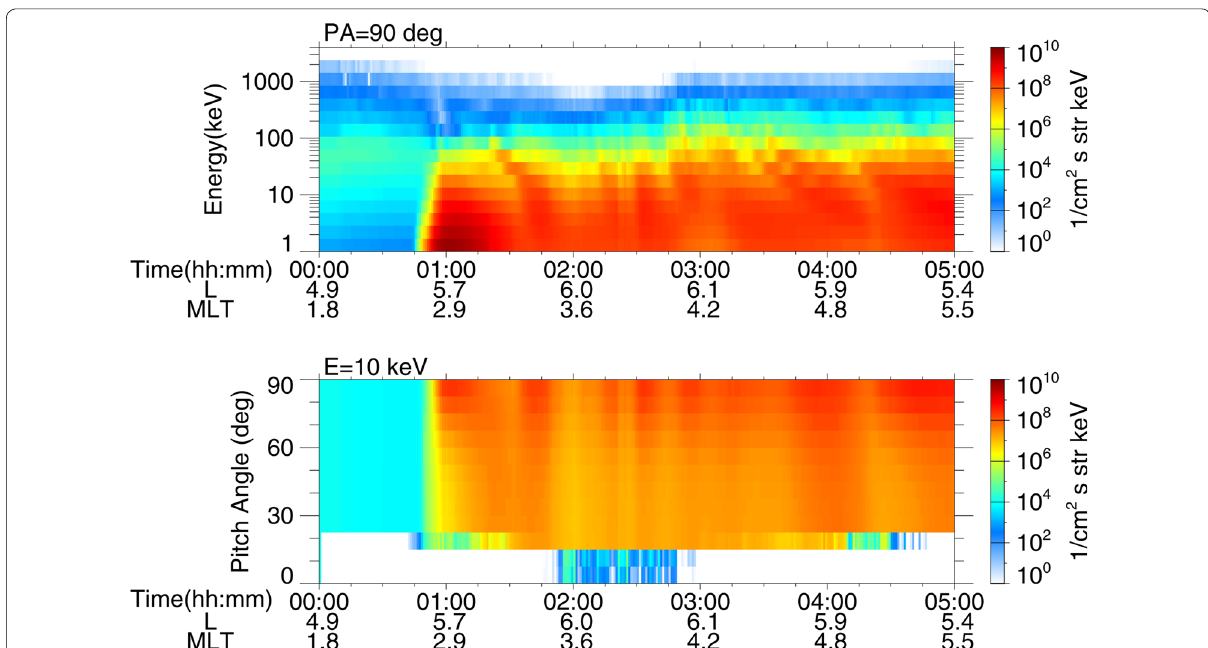
Fig. 5 Example of simulation results along the Arase trajectory: (top) energy versus time spectrogram of electrons with equatorial pitch angle of 90°, and (bottom) pitch angle versus time spectrogram of electrons with kinetic energy of 10 keV. The spectrograms are taken along a trajectory of